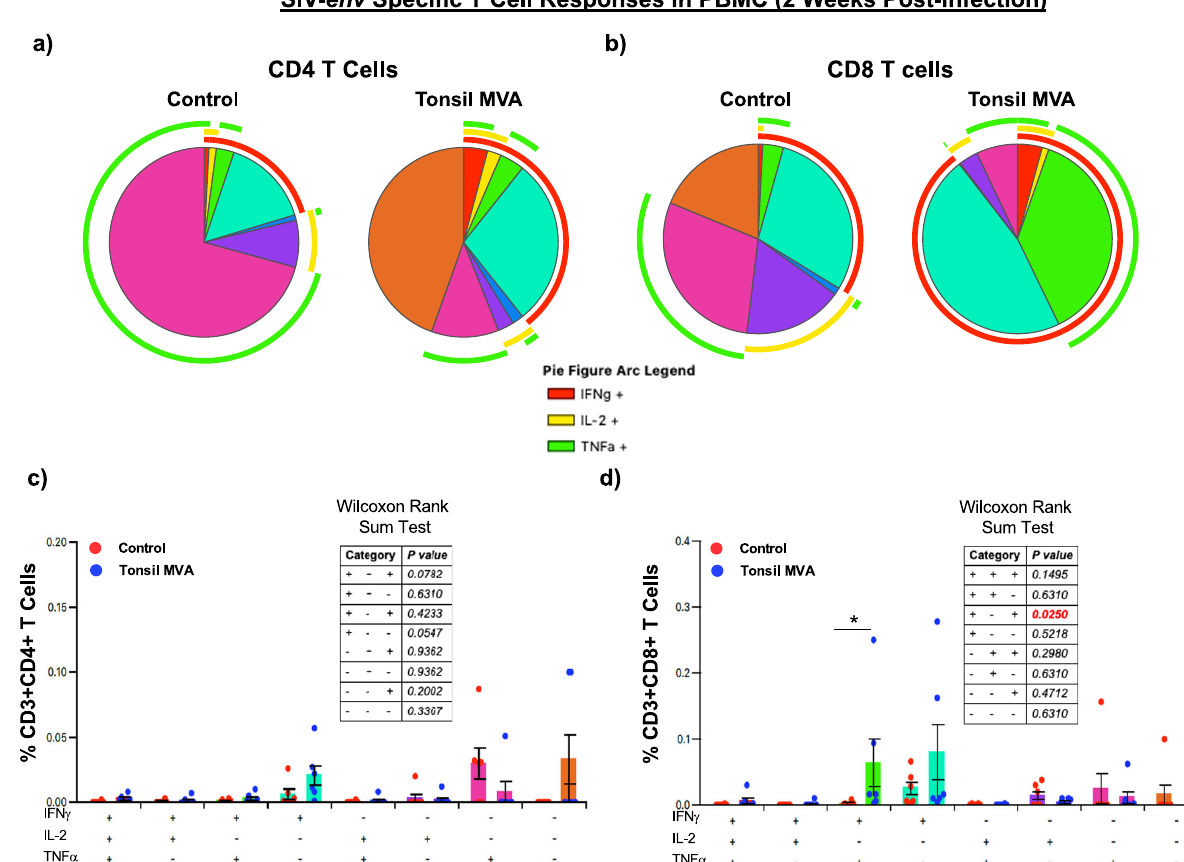
Fig. 7 | Tonsil vaccination induced signi fi cant levels of SIVmac239-env speci fi c poly-functionalCD8Tcellresponsesinperipheralblood. Qualitativeanalysisof SIVmac239-envspeci fi cIFN γ ,IL-2,andTNF α expressioninperipheralblood( a )CD4 and( b )CD8Tcellsofcontrol( n =6)andtonsilvaccinated( n =6)animalsat2weeks post infection. Frequency of ( c ) CD3 + CD4 + T cells and ( d ) CD3 + CD8 + T cells in